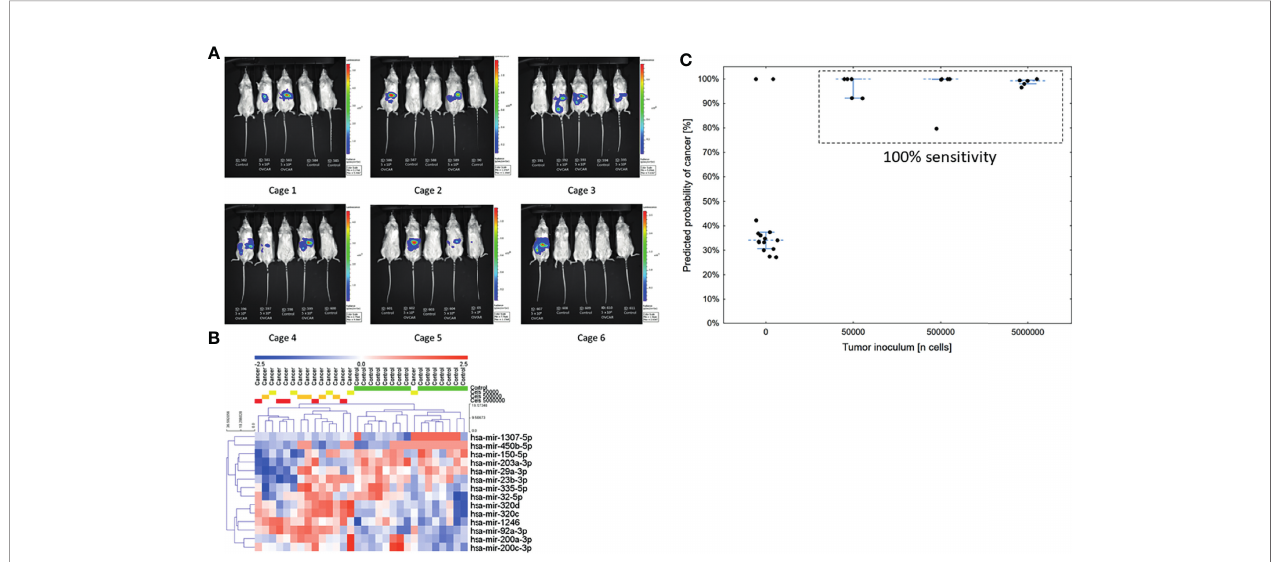
FIGURE 2 | Validation of the low volume disease model in an independent cell line across tumor volumes (n = 30). (A) Bioluminescent images of mice taken 28 days post-injection. Groups were randomized among the cages. (B) Unsupervised hierarchical clustering using only the 14 miRNAs previously reported in the serum neural network. (C) Predicted probability of cancer in the serum samples at 28 days using a neural network model. The cut-off for a positive test was set at